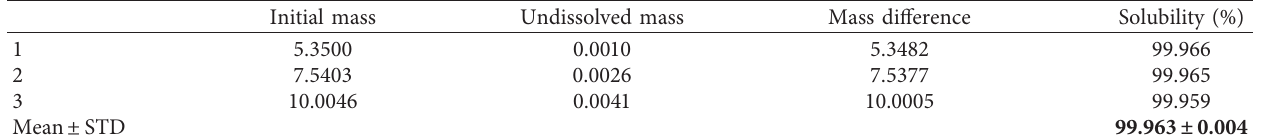
Table 10: Solubility of EC in tap water.